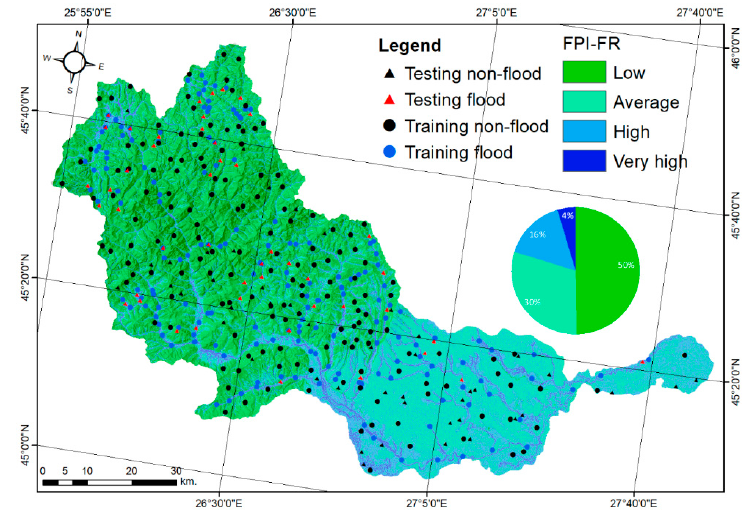
Figure 6. Flood Potential Index (FPI)–frequency ratio (FR) spatial distribution.